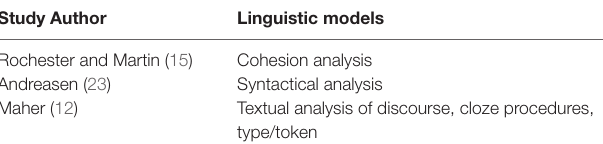
TABLE 2 | Table of linguistic